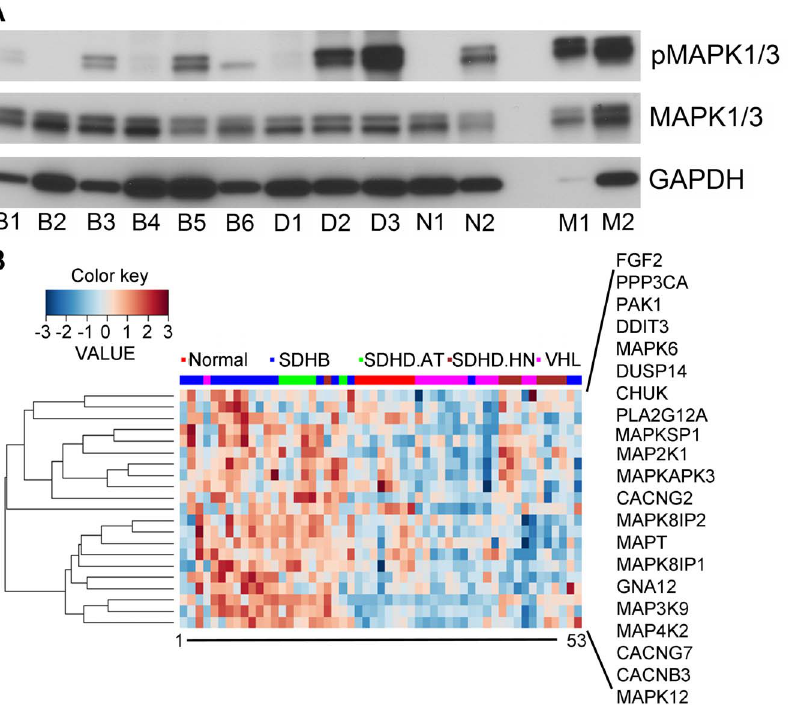
Figure 1. MAPK pathway representation in SDHB-derived PHEOs/PGLs. A. Western blot of pMAPK1/3, total MAPK1/3, and GAPDH in human PHEOs/PGLs. Patient and tumor information for each sample are presented in Table 1. Abbreviations: B) SDHB, D) SDHD, N) NF1, M) normal adrenal medulla. B. Heatmap showing expression of 21 MAPK pathway genes in pseudohypoxic PHEOs/PGLs. Expression of these 21 genes was significantly elevated in SDHB compared to normal medulla (p , 0.002). Each sample was assigned a number. The corresponding sample identifier from